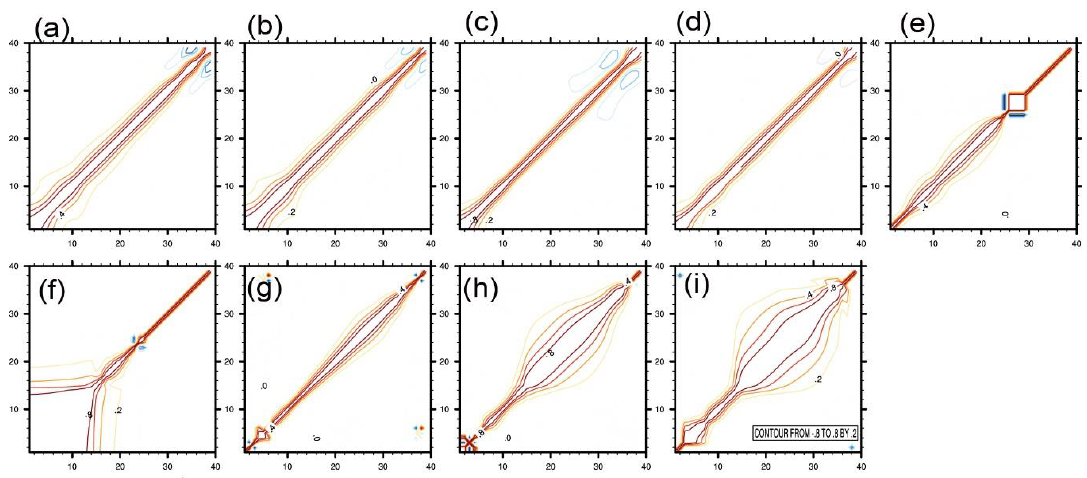
Figure 4. The vertical correlations for ( a ) u, ( b ) v, ( c ) t, ( d ) rh, ( e ) q c , ( f ) q r , ( g ) q i , ( h ) q s , and ( i ) q g . Contours are from –0.8 to 0.8 by 0.2.